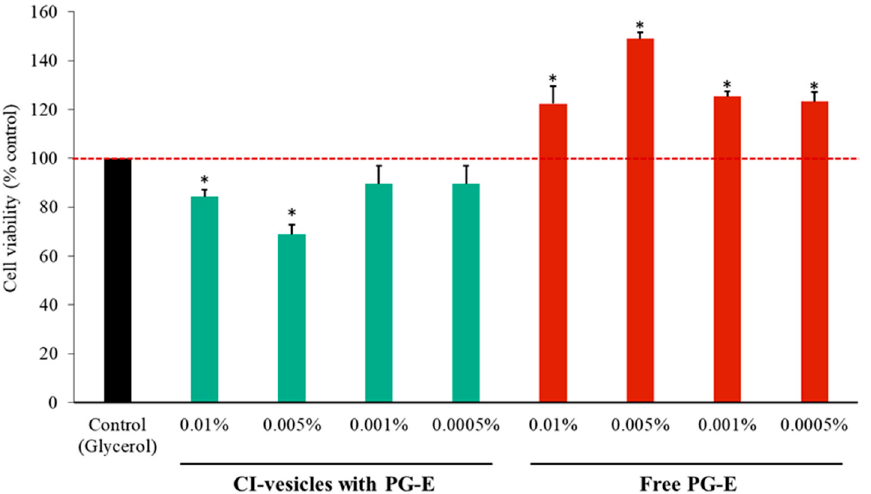
Figure 4. Viability of HaCaT cells incubated for 24 h with different concentrations of pomegranate extract (PG-E), encapsulated in cauliflower inflorescence vesicles (CI-vesicles) or free, as determined by the MTT assay. The results were normalized as a function of the glycerol cytotoxicity. Data are means ± SE ( n = 6). * p < 0.05, significantly different compared to the control group.